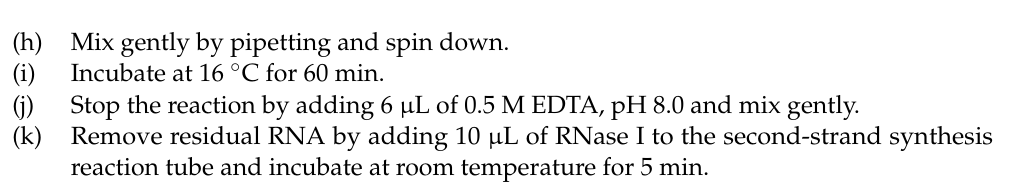
Table 7. Second-strand cDNA synthesis reaction mix. Component Volume First-Strand cDNA Synthesis Reaction Mixture 20 µ L Nuclease-Free